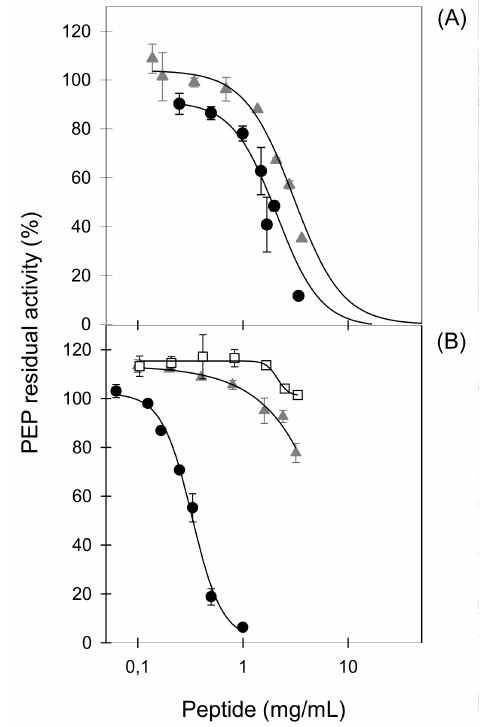
Figure 2. The concentration-dependent effect on prolyl endopeptidase (PEP) residual activity of peptides PKH11 and PACEI50L and their sequence variants obtained by W replacement with A. ( A ) PKH11 (SVDGKEDLIW; black circles) and its sequence variant PKH11-v1 (SVDGKEDLIA; grey triangles); ( B ) PACEI50L (RKWHFLW; black circles), and its two sequence variants PACEI50L-v1 (RKWHFLA; grey triangles) and PACEI50L-v2 (RKAHFLA; white